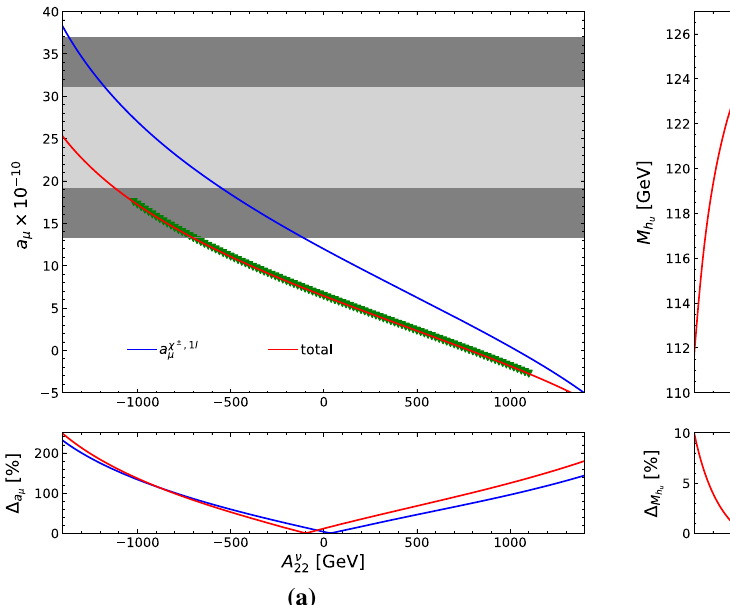
is varied instead 22